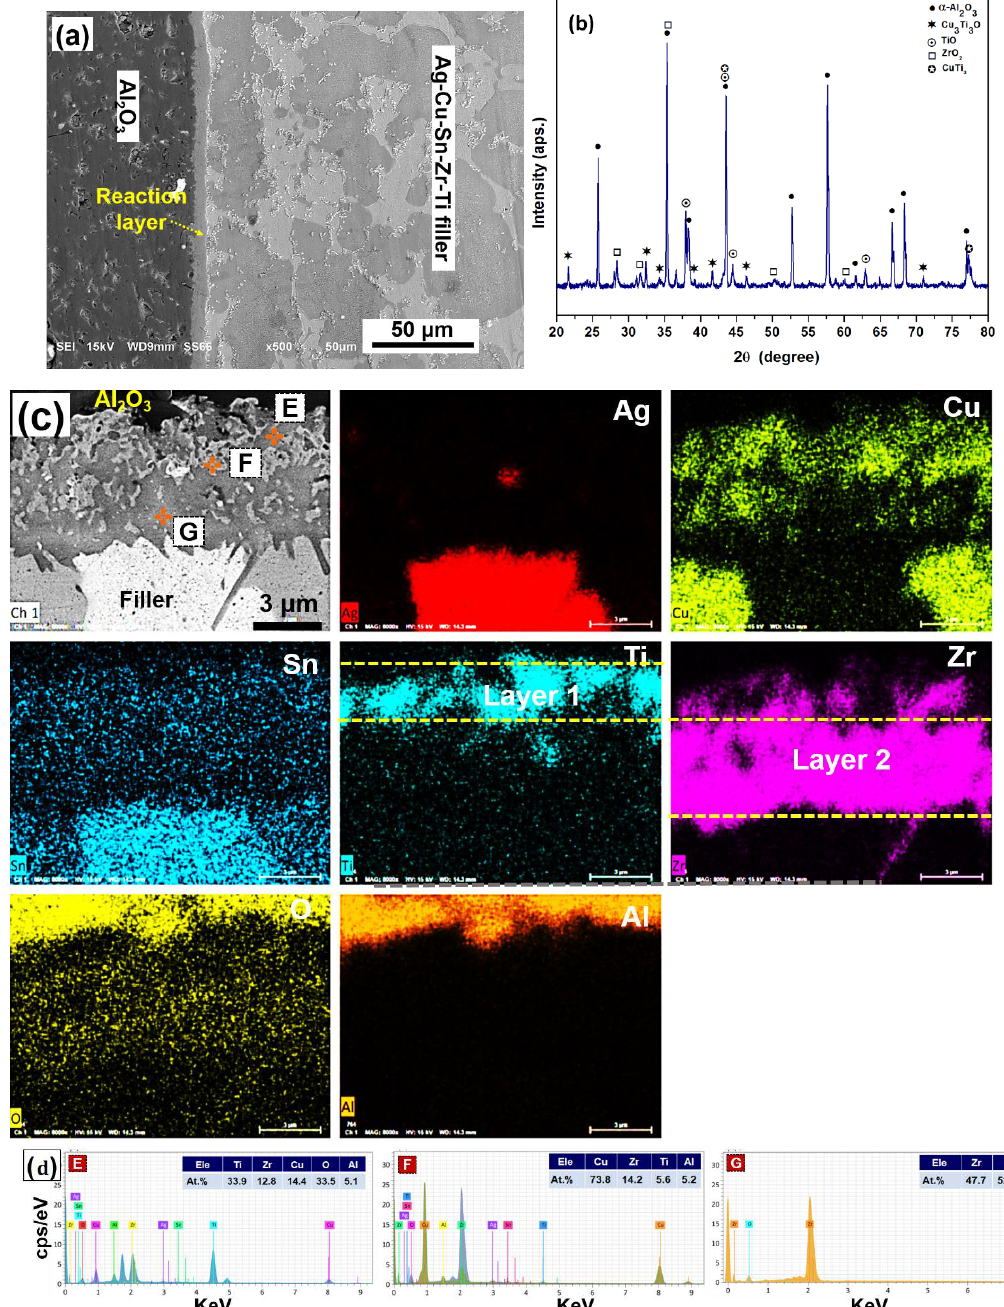
Figure 6. Al 2 O 3 /Cu joints brazed by using Ag-18Cu-6Sn-3Zr-1Ti filler: ( a ) interface microstructure; ( b ) XRD pattern of reaction zone adjacent to Al 2 O 3 ; ( c ) elemental mapping of brazed Al 2 O 3 /Ag-18Cu-6Sn-3Zr-1Ti interface elements Ag, Cu, Sn, Ti, Zr, O and Al; ( d ) and EDS analysis of spot E, F and G.